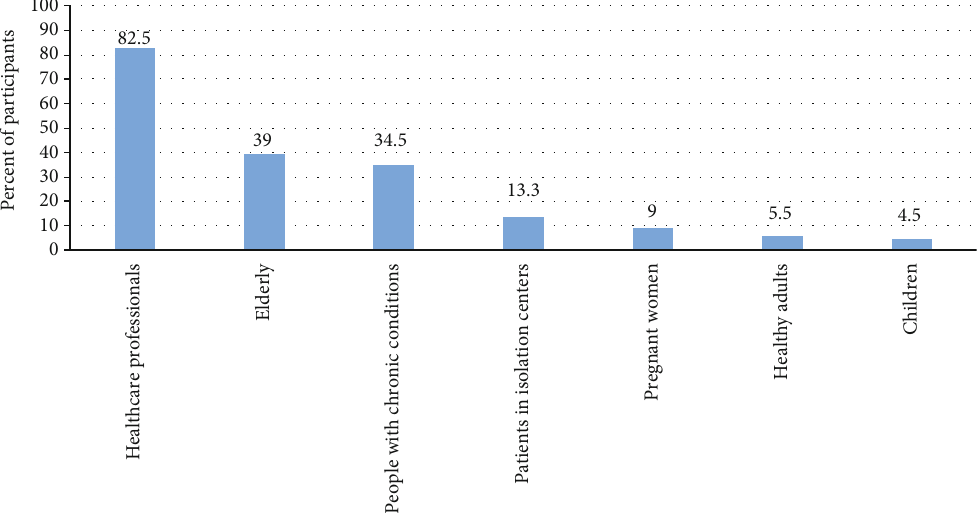
Figure 3: Perception of participants about criteria for vaccination ( n = 400 ). Table 4: Acceptability of the participants regarding COVID-19 vaccination based on their professions.